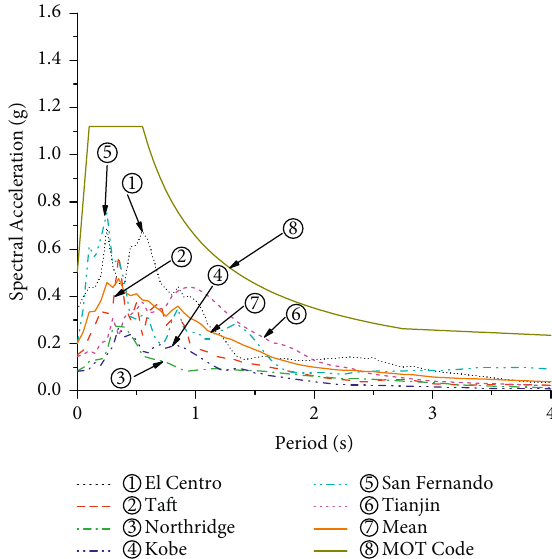
Figure 3: Acceleration response spectrum of the selected ground motions.